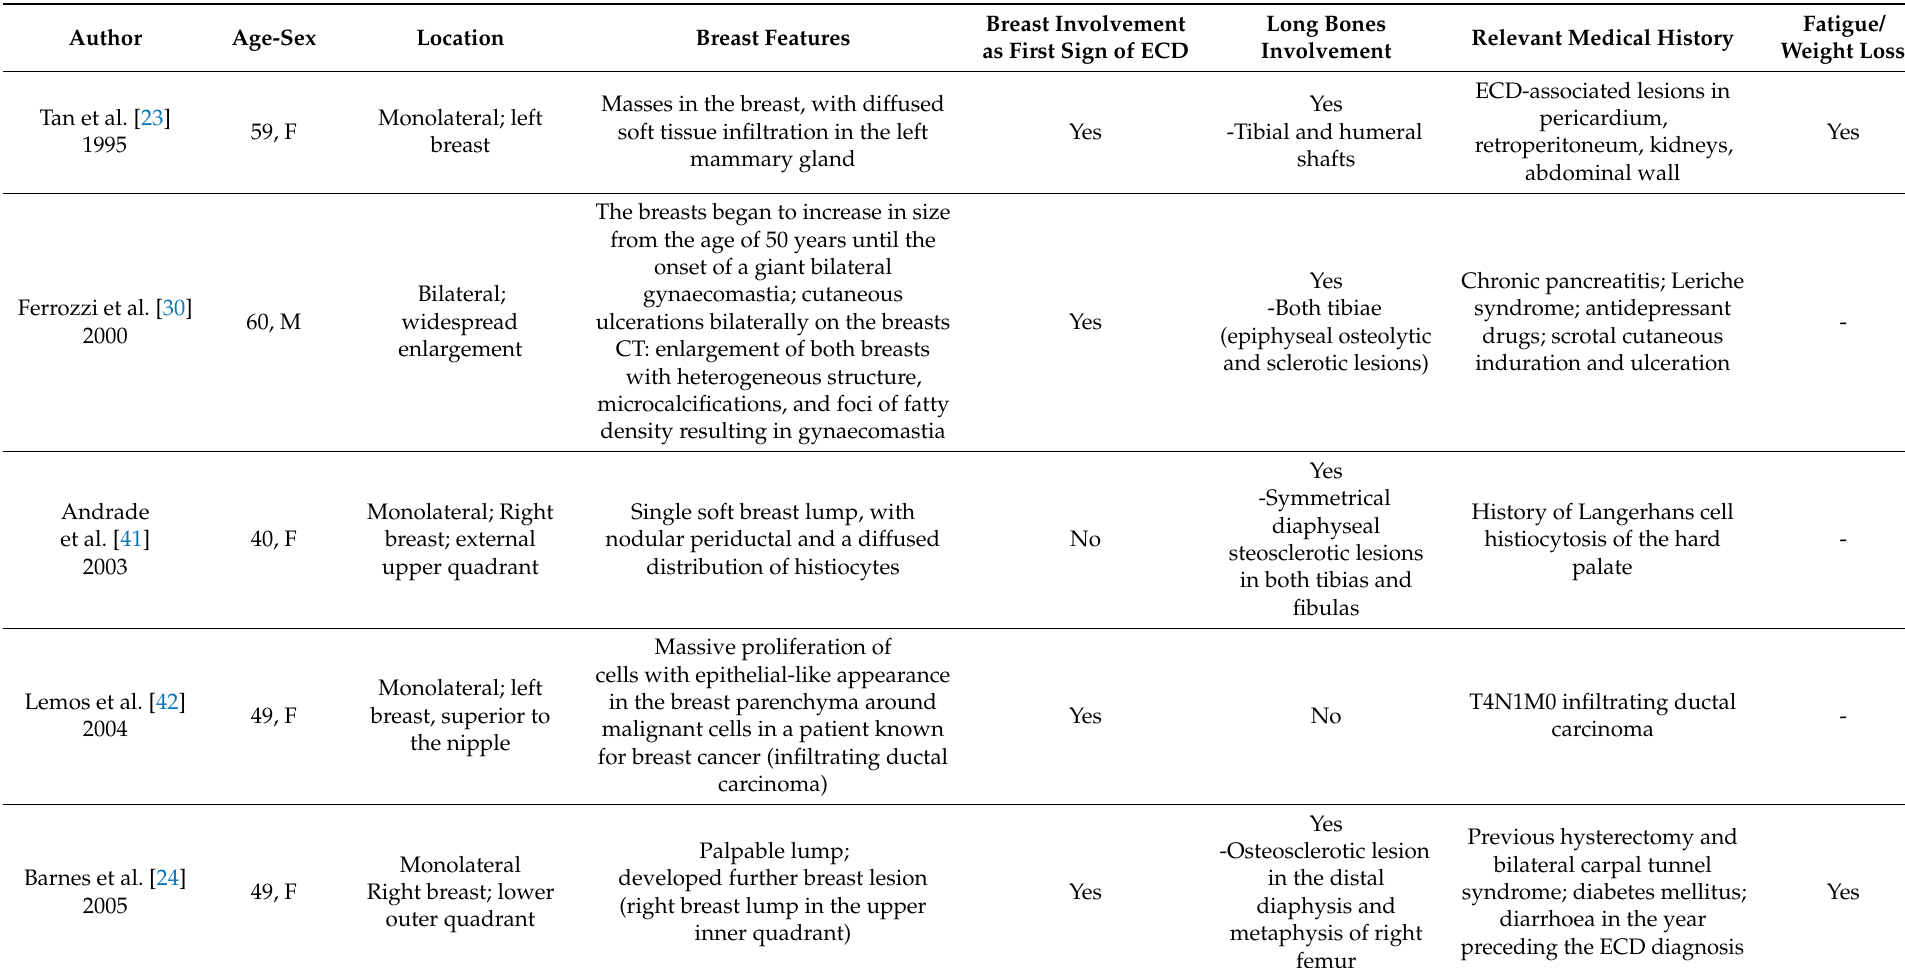
Table 1. Breast involvement in Erdheim–Chester disease in the English